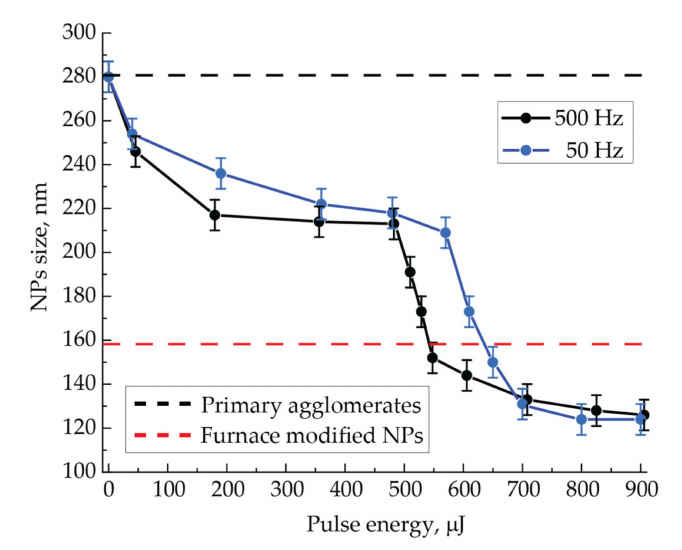
Figure 4. Dependencies of NPs size at the output of the cell on pulse energy of laser radiation with the wavelength of 1053 nm at the pulse repetition frequencies of 50 and 500 Hz and the aerosol flow rate of 50 mL/min.